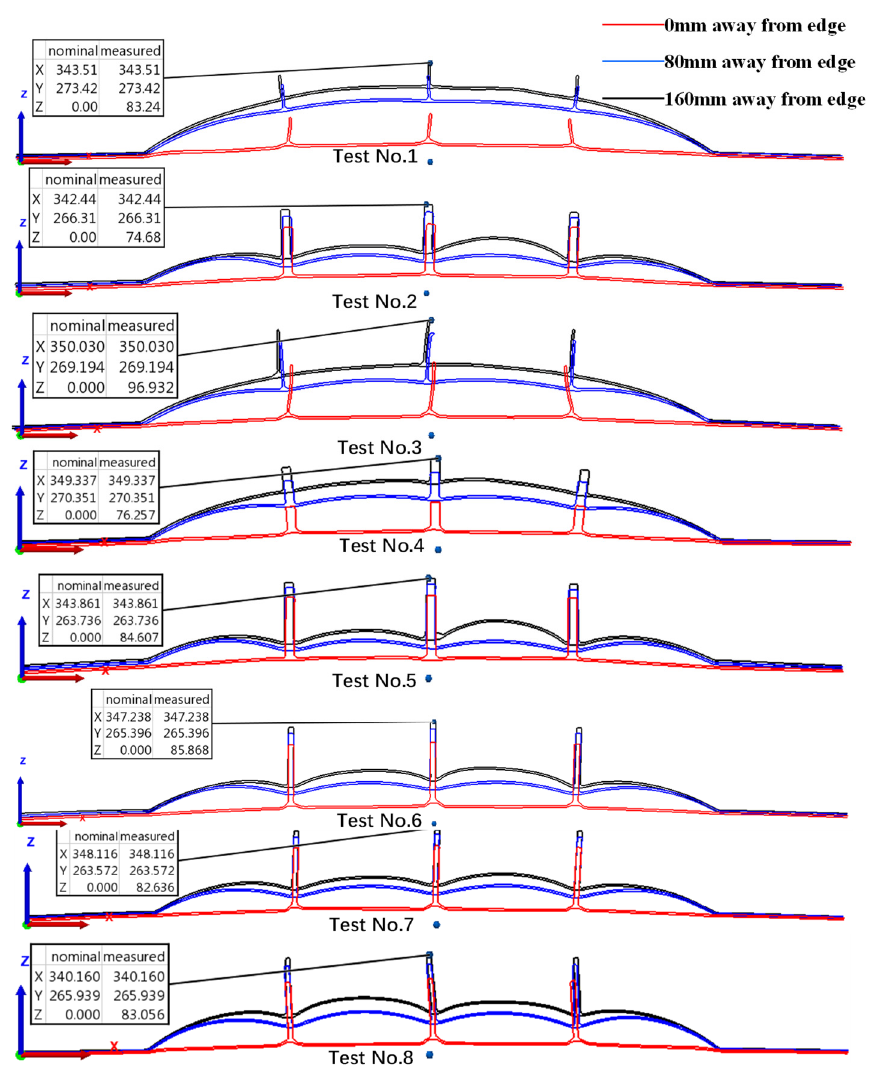
Figure 10. Displacement nephogram using the 3D scanner technique: ( a ) Test No. 1, ( b ) Test No. 5.